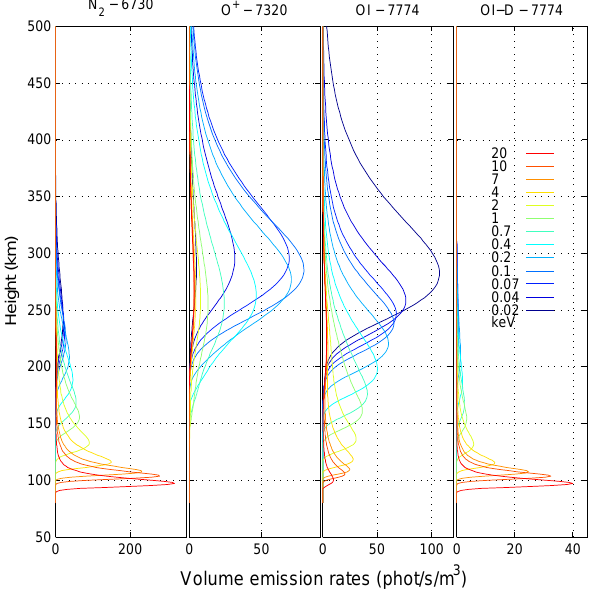
Fig. 1. Modelled height profiles of emission rates using monoen- ergetic input spectra of varying peak energies, and constant flux of 1mW/m 2 : (a) N 2 1P bands (ASK1), (b) O + line at 732.0nm (ASK2) (c) 777.4nm from direct excitation (ASK3), (d) 777.4nm from dissociative excitation (ASK3).